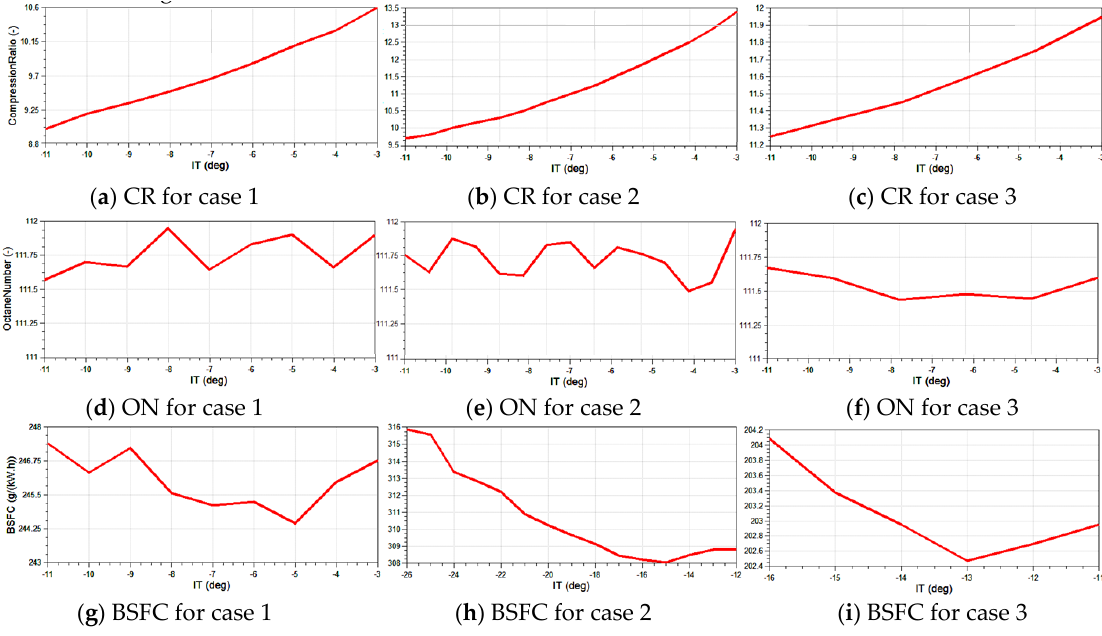
Figure 11. The CR and ignition timing (IT) optimization in step 2.